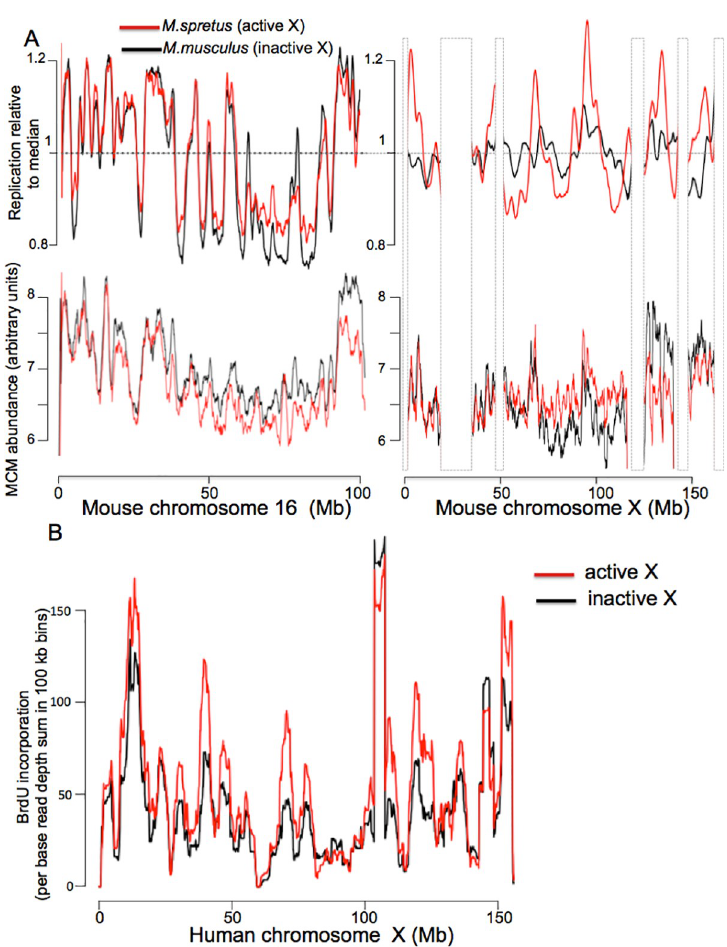
Fig 9. MCM distribution and replication on the X chromosome. (A) Replication (upper panel) and MCM binding (lower panel) in mouse Patski cells for chr16 (left) and chrX (right). M. musculus and M. spretus parental chromosomes are shown in black and red, respectively. Replication, measured by S-seq, is plotted as fraction of median read depth, with larger fluctuations from the median reflecting more active replication, separately to each of two chromosomes. MCM abundance is plotted as a ratio of MCM2-ChEC to sonicated G1 DNA read depths using all read sizes, separately for each of two chromosomes as explained in the Materials and Methods section.All Mcm2-ChEC fragment sizes are included in the analysis. (B) Fluctuation in BrdU incorporation during the first half of S-phase across two copies of chr. X in human female cell line GM12878 (data from ENCODE consortium